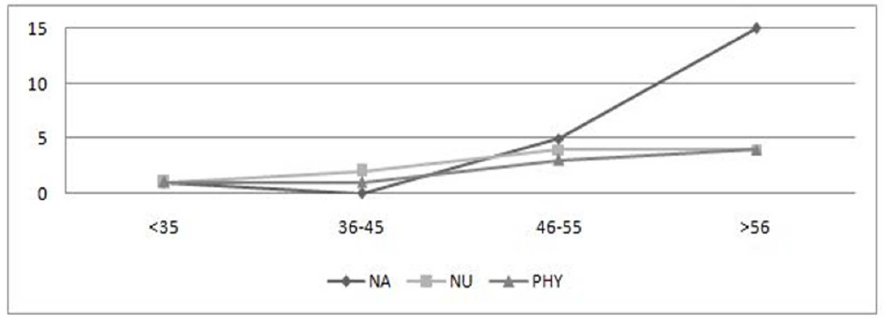
Figure 3. Age distribution of cardiovascular disorders. NA, nursing aides; NU, nurses; PHY, physi- cians.